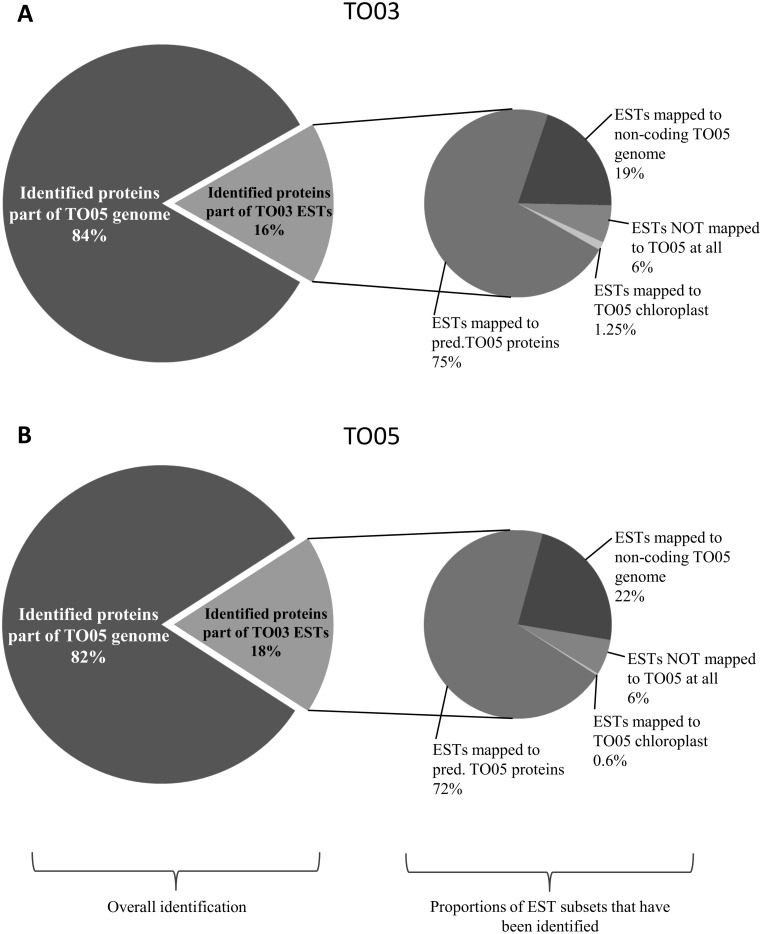
Comparison between EST-mapped proteomics datasets of TO03 and TO05, emphasizing the similarity in their genomes.A) Results for TO03 (plusEST). B) Results for TO05 (plusEST). The left side of the panel shows the proportion of identified predicted proteins coming from the TO05 genome vs. the TO03 transcriptome (ESTs). The right side of the panel shows the proportion of the different types of ESTs that have been mapped by the peptides coming from the LC-MS/MS. Even though we used the combined database including all known TO05 and TO03 predicted proteins, neither strain shows bias towards its own subset of proteins.